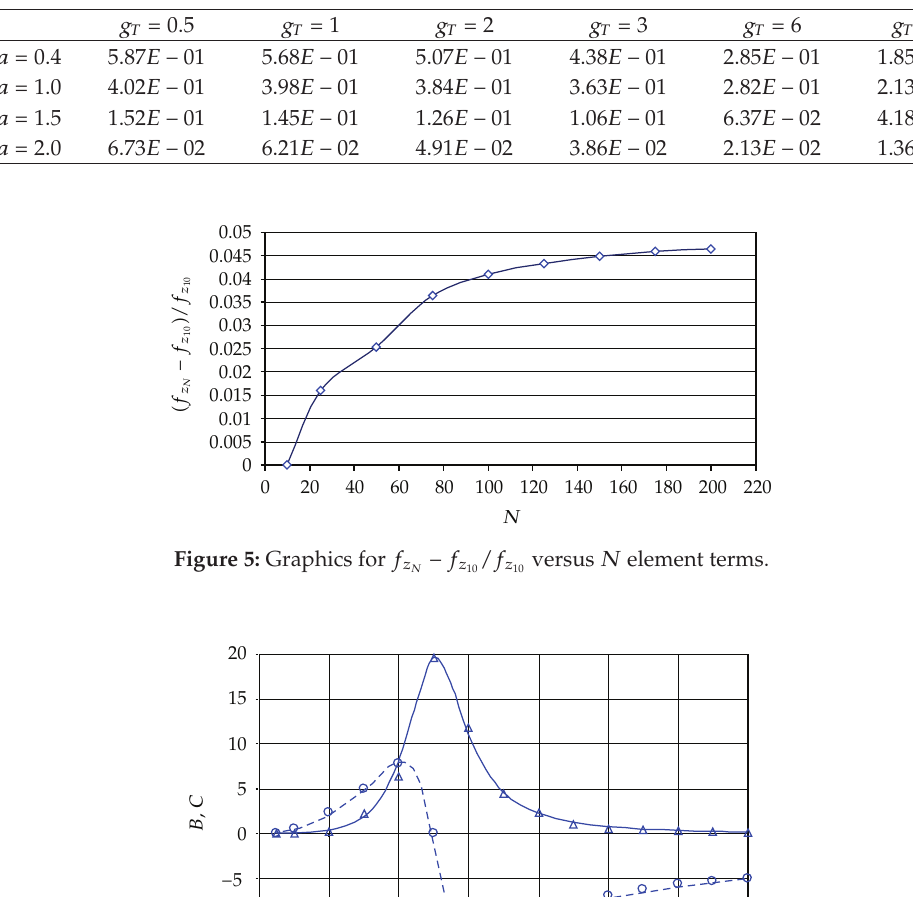
Table 2: Modulus of the inner pressure p in0 / (cid:4) H/ 2 (cid:5) for various values of g T and ka , for a floating OWC device with mass moment of inertia I (cid:8) 1738 . 87tn · m 2 .